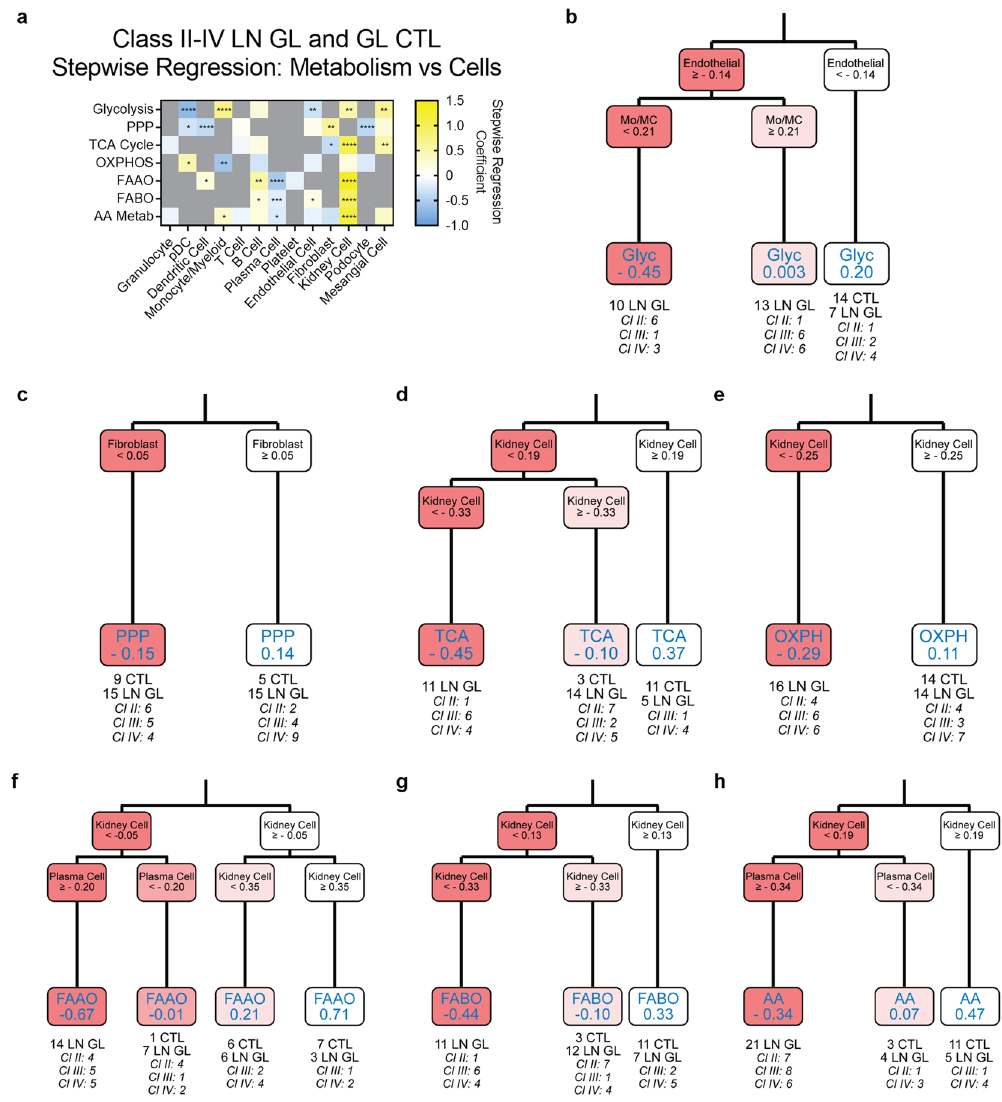
Figure 4. Metabolic gene expression changes in LN GL are associated with changes in the EC, kidney cell, and fibroblast gene signatures. ( a ) Stepwise regression coefficients and ( b–h ) CART analysis for metabolic pathway signatures in all glomerular LN samples and CTLs. Values in the final CART leaves for each process represent the average GSVA score of samples that were assigned to that leaf. Each resulting CART decision tree was pruned once. For all calculations, the following sample numbers were used: LN GL [CTL (n = 14), Cl II (n = 8), Cl III/IV (n = 22)]. Significant p-values in ( a ) reflect significant coefficients in the stepwise regression model. *, p < 0.05; **, p < 0.01; ***, p < 0.001; ****, p <